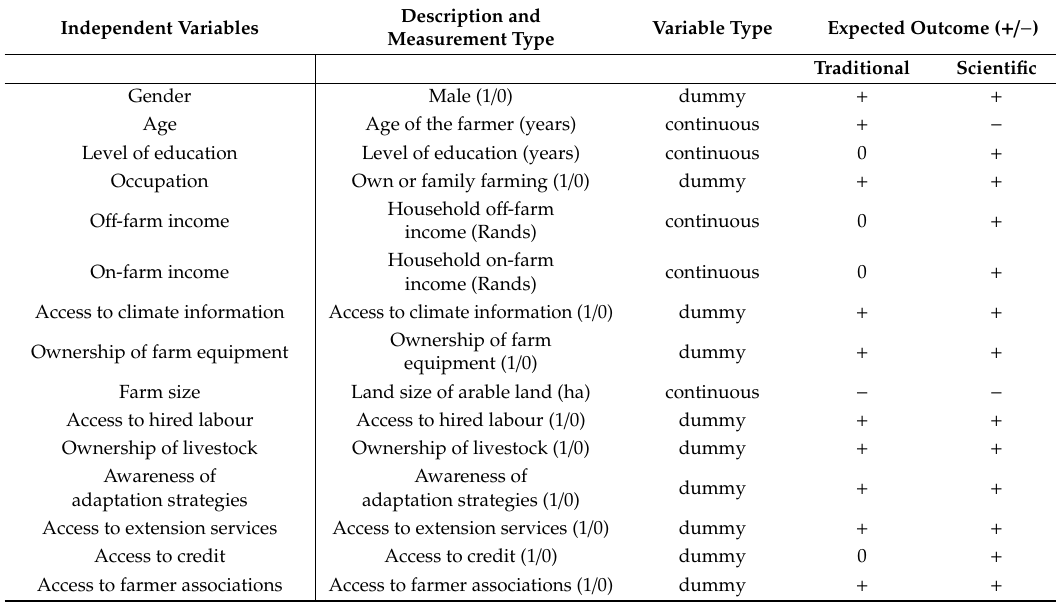
Table 1. Description of the explanatory variables used in a binary logistic regression model and expected